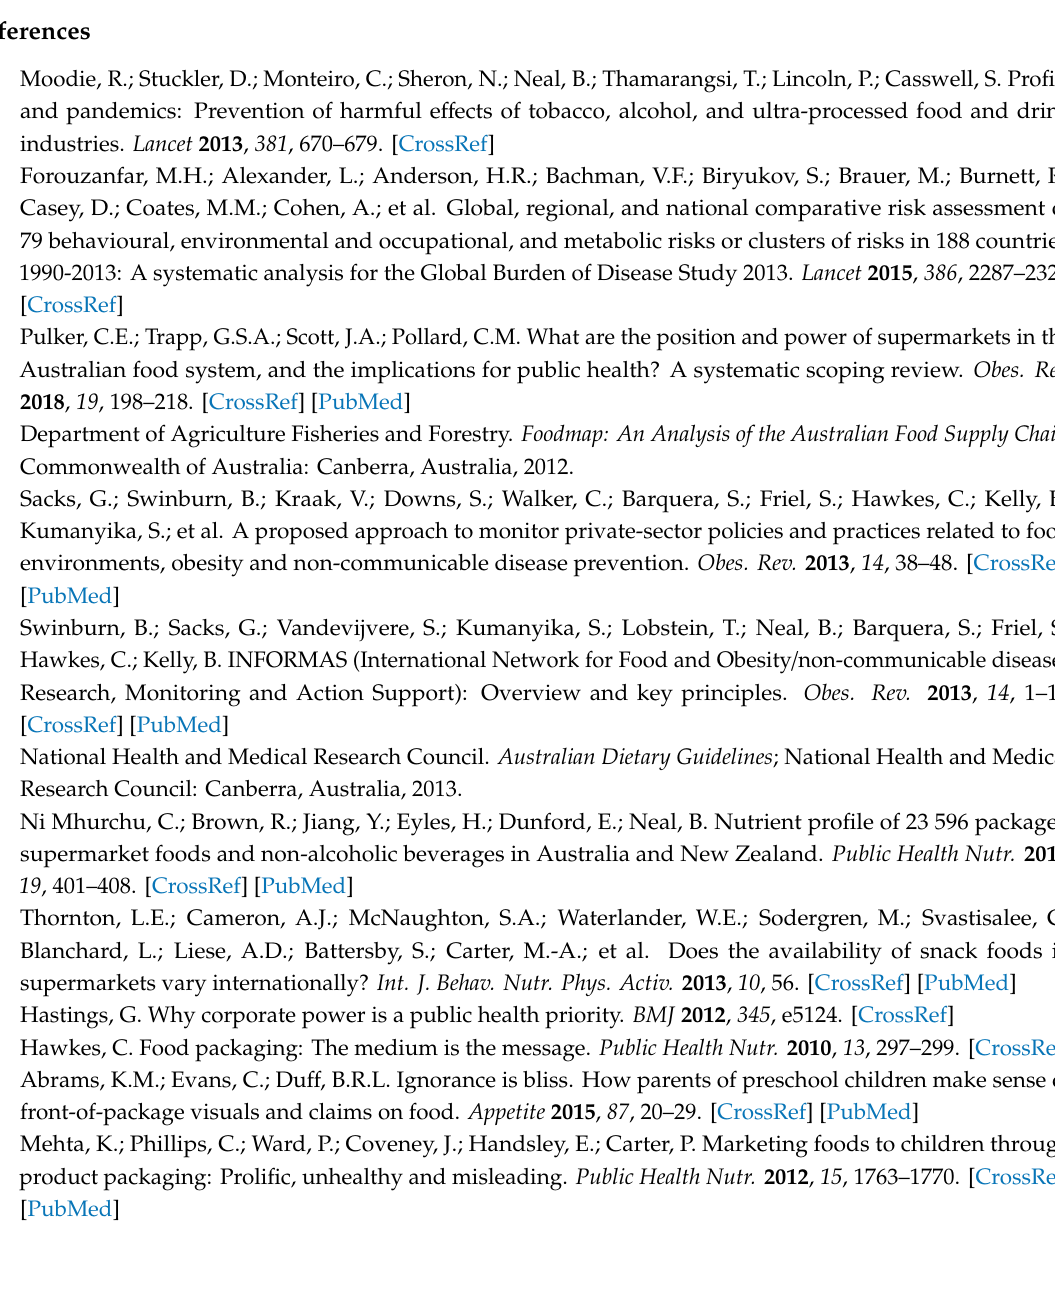
Figure S1: Food items used as stimuli for focus groups, Table S1: Consolidated criteria for reporting qualitative studies (COREQ): 32-item